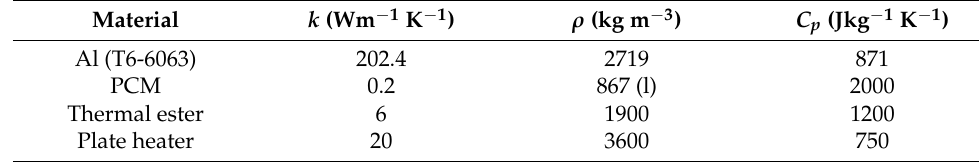
Table 2. Physical properties of the aluminum sheet, paraffin, plate heater, and thermal